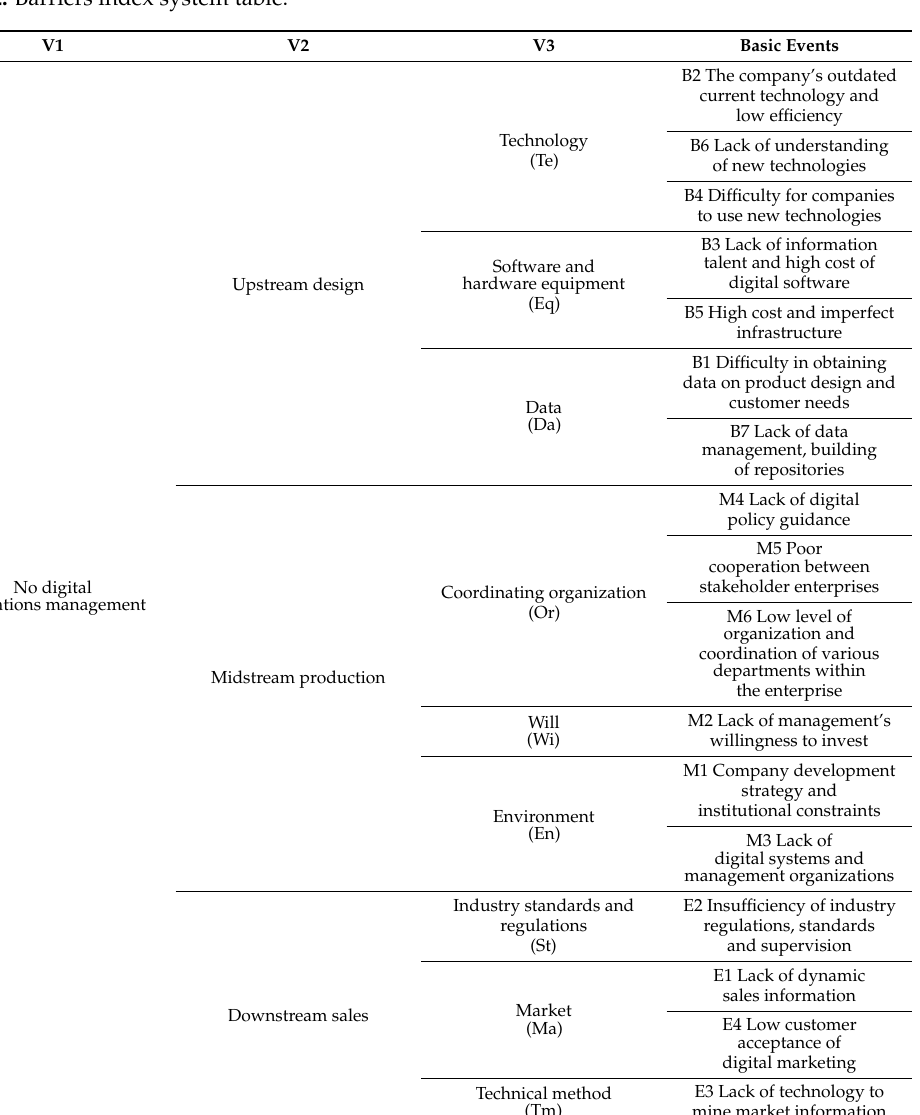
Table 2. Barriers index system